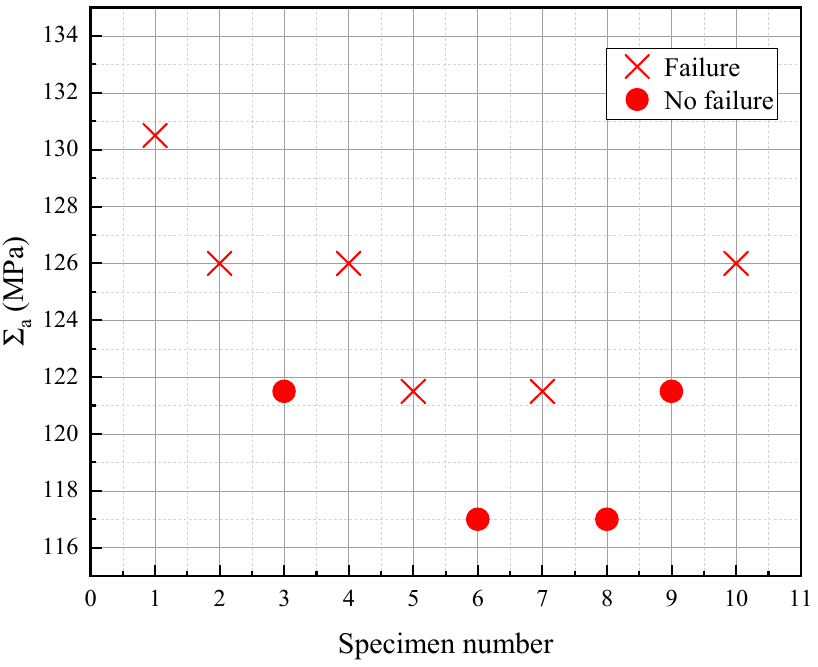
Figure 8. Fatigue limit prediction based on the developed method.